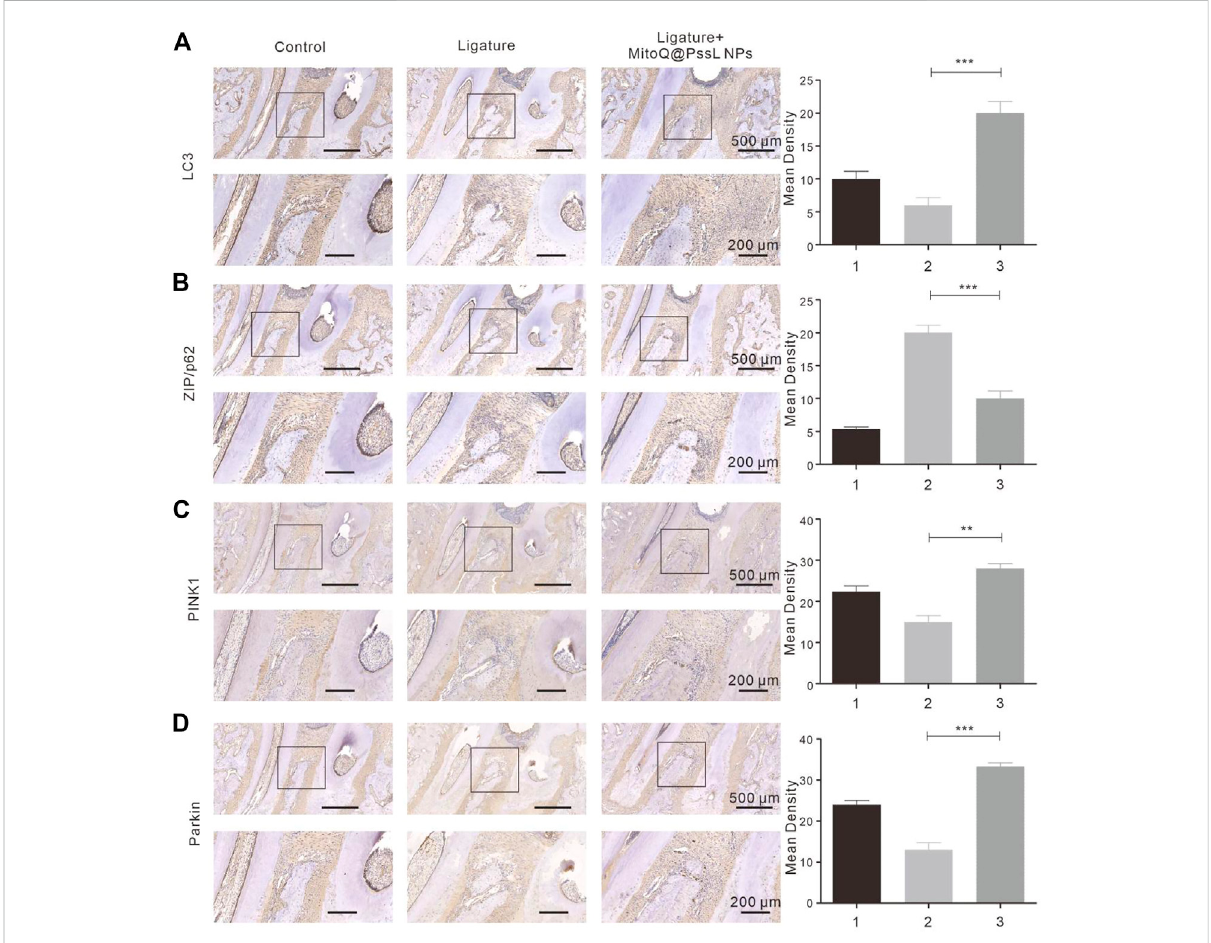
FIGURE 7 The expressions of (A) LC3, (B) ZIP/p62, (C) PINK1, (D) Parkin were detected using immunohistochemistry (50×, 100×). Partial enlargements were shown in the black boxes. 50× Scale bar: 500 μ m. 100× Scale bar: 200 μ m. The corresponding quantitative analysis of LC3, ZIP/p62, PINK1, Parkin expression in immunohistochemical staining images. (** means p < .01, ** means p <